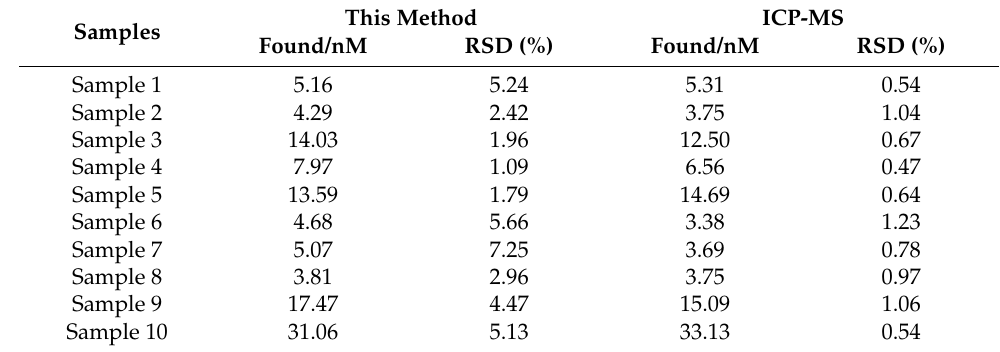
Table 2. Detection of Cu 2+ using this method and ICP-MS ( n = 3).